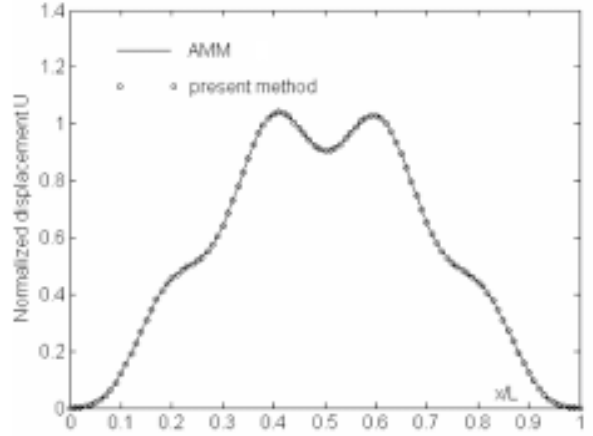
Fig. 3. Normalized displacement under a moving force with α = 0 . 11 and a beam with β = 0 . 03 .